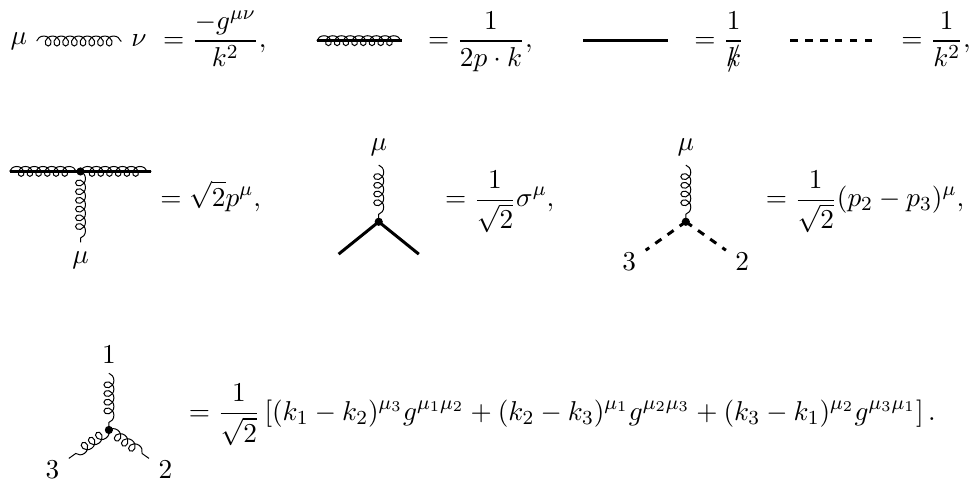
Figure 1 . Color ordered Feynman rules from Wilson lines expansion together with N = 4 SYM propagators and 3-point vertexes. A coil denotes ordinary gluon, solid line denotes fermion and dashed line stands for scalar. The Feynman rules coming from Wilson line expansion could be easily understood using the representation of the latter as eikonal quark line [70]. To denote eikonal quark line we use a coil crossed by a